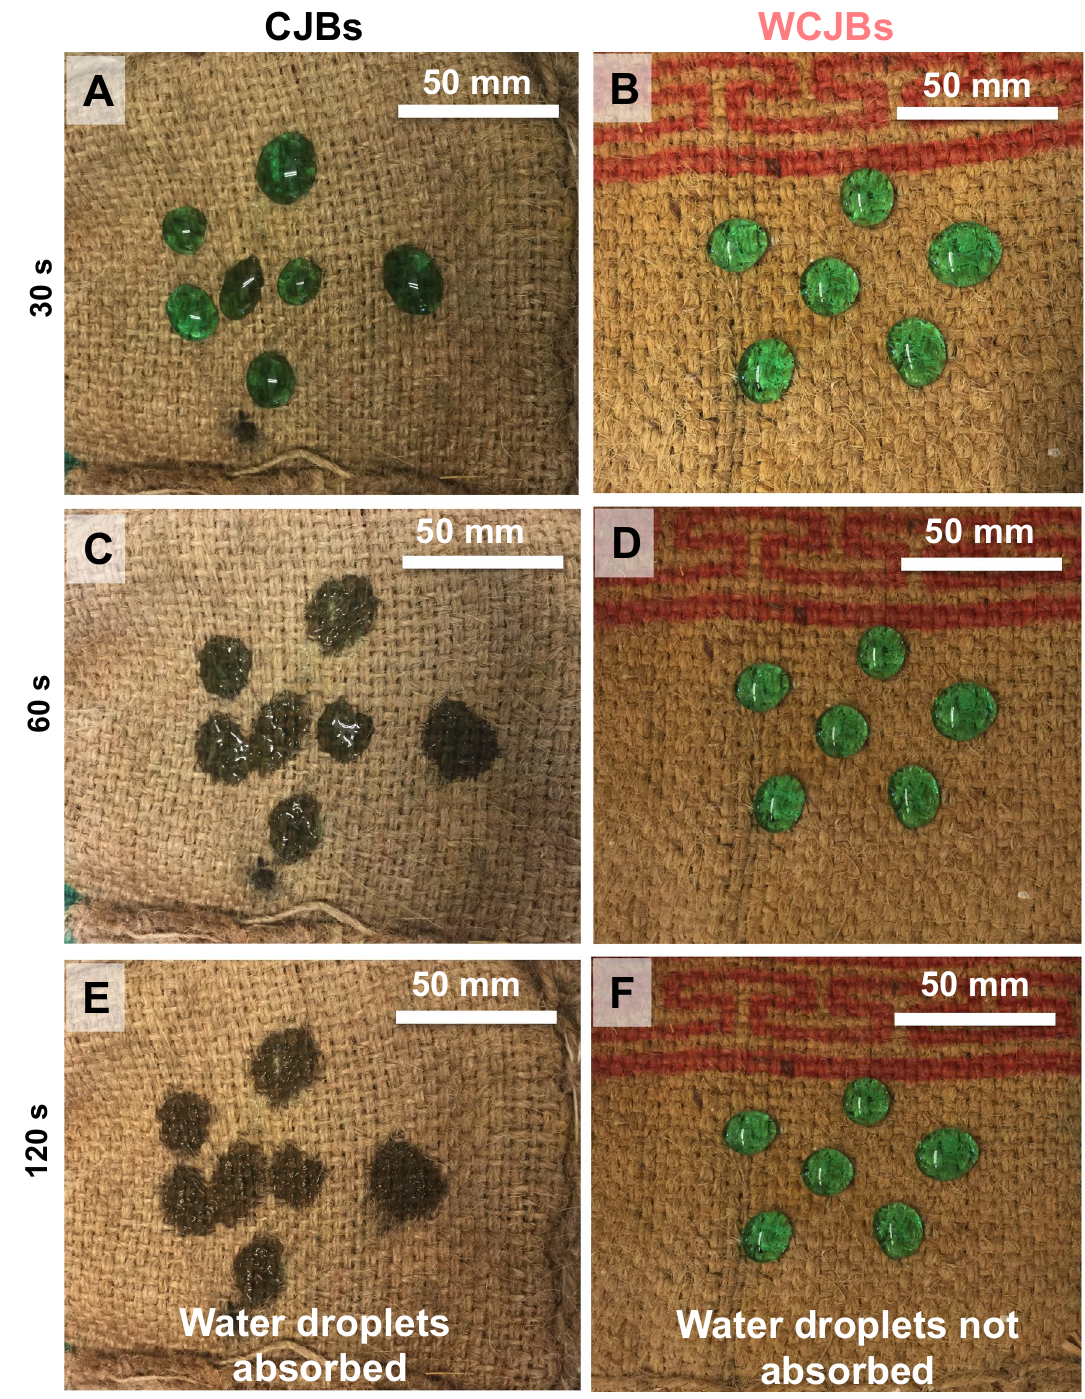
Figure 3. Representative photographs showing time-dependent wetting of control jute bags (CJBs) and wax-coated jute bags (WCJBs). At 30 s, water droplets began to seep into the CJBs, whereas droplets could not penetrate into the WCJBs ( A , B ). Within 1 min, CJBs showed significant wetting; in contrast, water droplets did not spread on the WCJBs ( C , D ). From 2 min onwards, water droplets were completely absorbed by the CJBs, whereas the droplets on WCJBs could not penetrate even after > 3 h ( E , F ). (Note: we added dye to color the water in order to serve as a visual aid; experiments without dye yielded identical